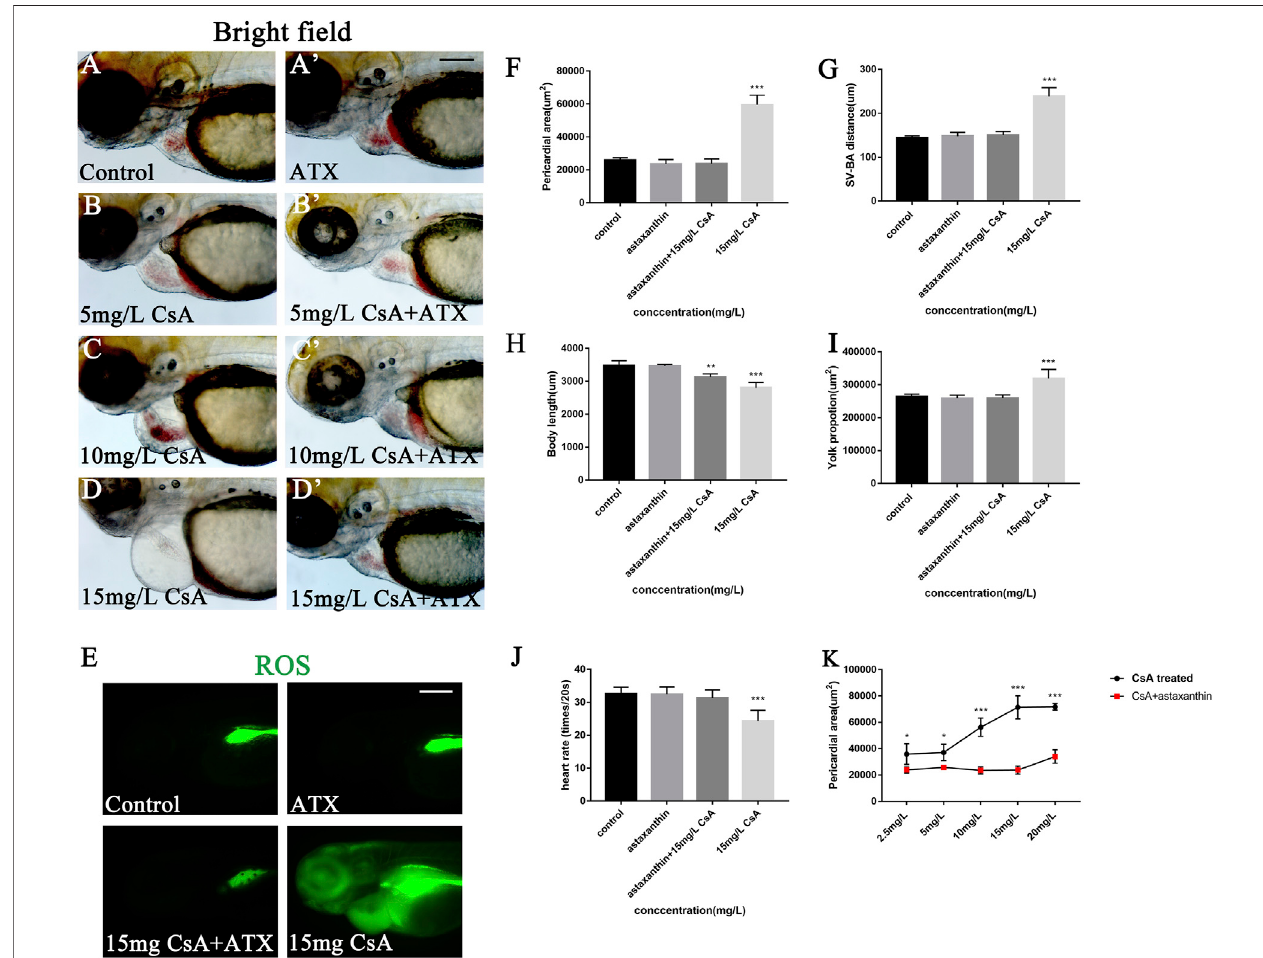
FIGURE 6 | ATXrescuedthecardiacdevelopmentaltoxicityinducedbyCsA. (A-D) ATXrescuedcardiacdefectsin72 hpfzebra fi shexposedtoCsAat5 mg/L,10 mg/L, 15 mg/L. (E) ATXrescuedROSstainingof72 hpfzebra fi shexposedtoCsA. (F) ATXrelivedpericardialareaof72 hpfzebra fi shexposedtoCsA( n (cid:1) 15.Comparedwithcontrol: * p < 0.05,*** p < 0.001,mean ± S.D). (G) ATXrescuedthedistanceofSV-BAof72hpfzebra fi shexposedtoCsA( n (cid:1) 15.Comparedwithcontrol:*** p < 0.001,mean ± S.D).SV: sinusvein;BA:arterybulb;scale:100 mm (H) ATXrescuedthebodylengthof72 hpfzebra fi shexposedtoCsA( n (cid:1) 15.Comparedwithcontrol:*** p < 0.001,mean ± S.D). (I) ATX rescued yolk sac area of 72 hpf zebra fi sh exposed to CsA ( n (cid:1) 15. Compared with control: * p < 0.05, mean ± S. D). (J) ATX rescued the heart rate of 72 hpf zebra fi sh exposed to CsA ( n (cid:1) 15. Compared with control: *** p < 0.001, mean ± S. D). (K) dose-response curve. Scale bars:100 µm (A-H) .